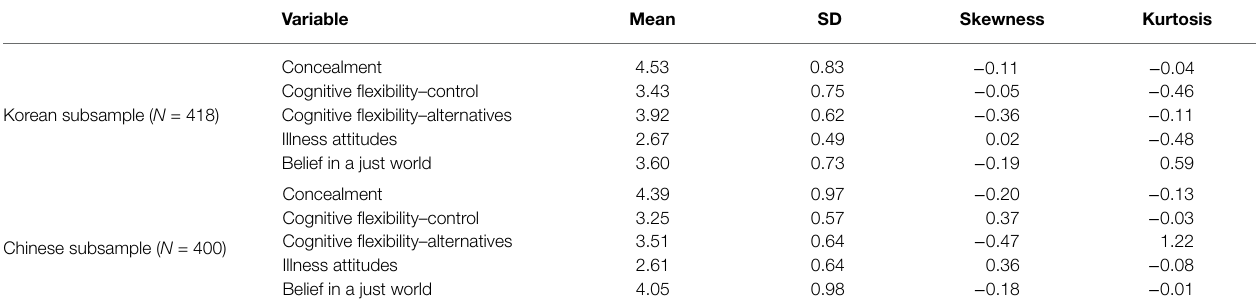
TABLE 1 | Descriptive statistics for measurement variables.